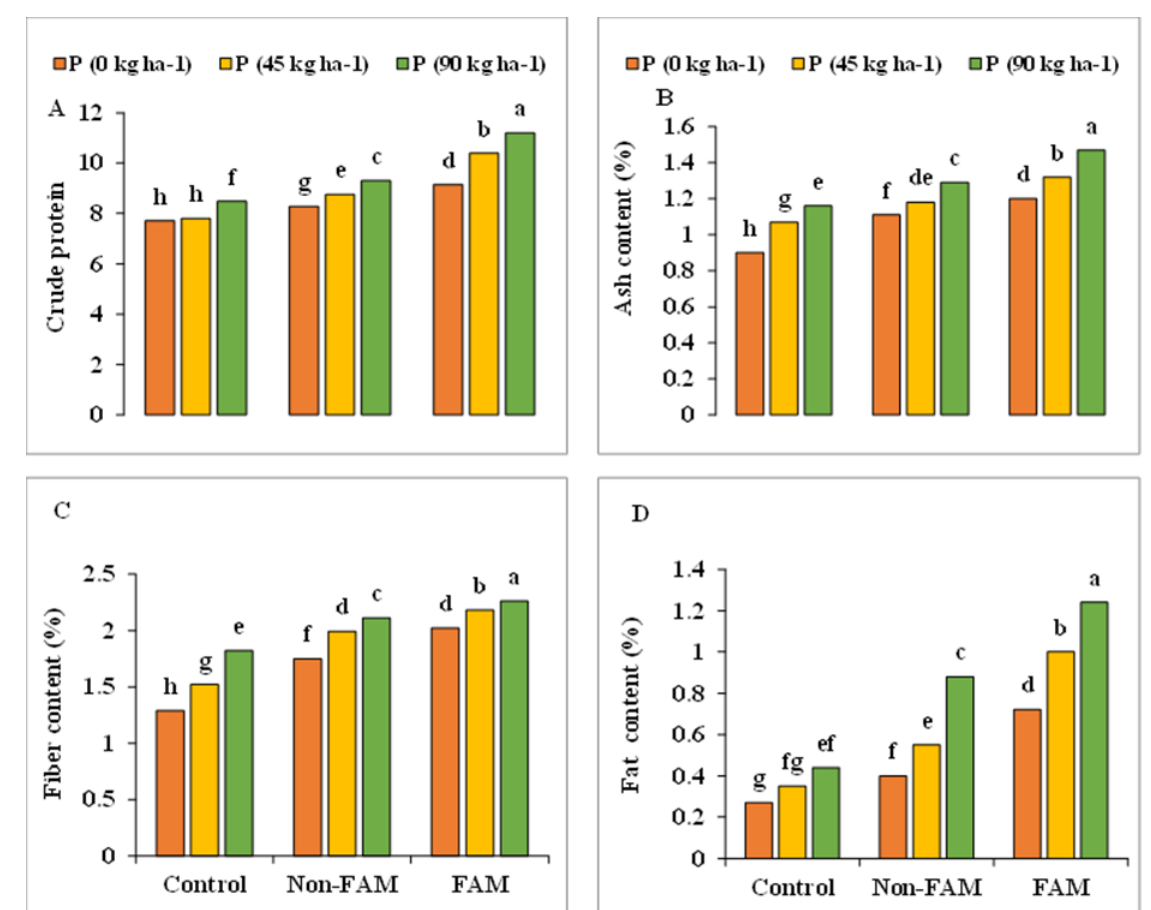
Figure 4. Combined use of fermented/non-fermented animal manure and phosphorus fertilizer on the biochemical parameters of wheat. ( A ) Crude protein content, ( B ) ash content, ( C ) fiber content, ( D ) fat content. Columns with different letters are significantly different from one another at a level of significance of p < 5%.